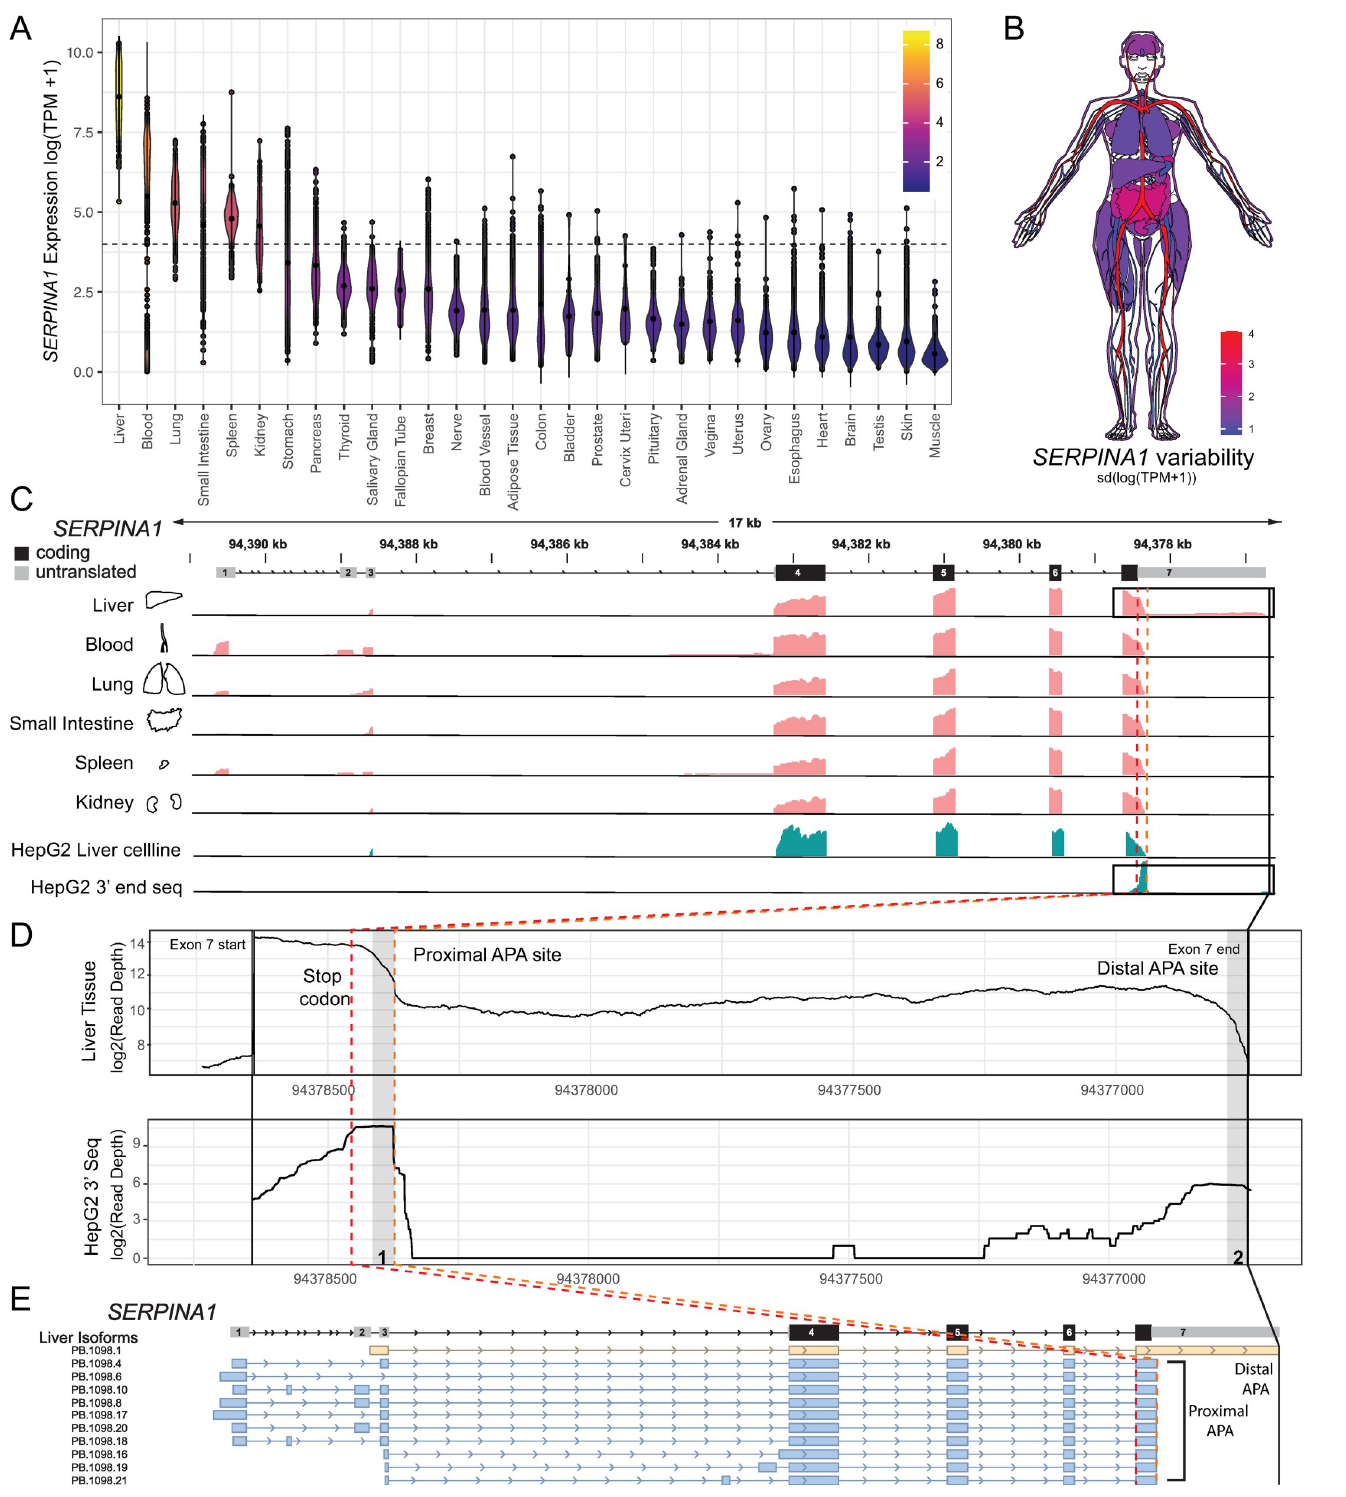
Fig 1. Tissue expression and alternative polyadenylation of the SERPINA1 mRNA. A) Tissue expression in Transcripts per Million (TPM) on a log scale for SERPINA1 mRNA for 17382 samples sequenced by the GTEx RNA-seq consortia [10,11,62].The six tissues with median SERPINA1 expression above average (~1000 TPM, indicated with dashed line) were further analyzed. B) Variation (as measured by the tissue specific standard deviation) in tissues. We observe particularly high levels of variation among individuals within blood samples. C) Read coverage of GTEx RNA-seq data for the six tissues highly expressing SERPINA1 mRNA are shown